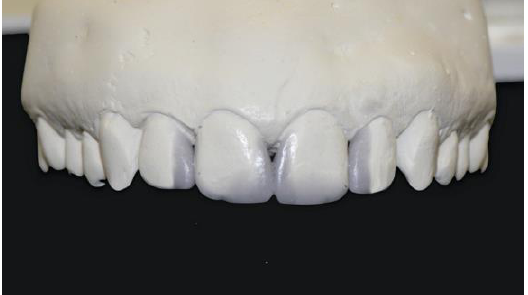
Figure 3. The diagnostic wax-up reveals a favorable 82% width-to-length ratio of the teeth restored with additional restorations.